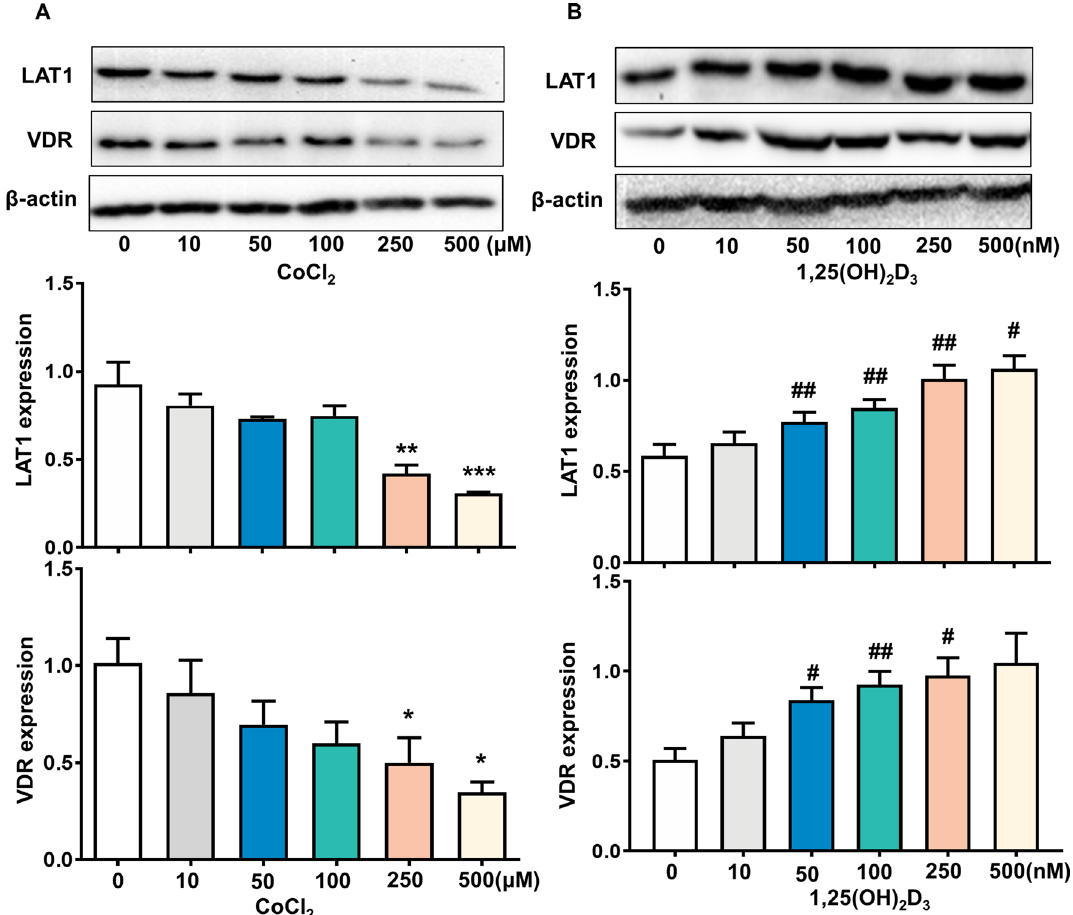
Figure 2. Effects of 1,25(OH) 2 D 3 and CoCl 2 on LAT1 and VDR expression in placental trophoblasts. ( A ) Protein expression for LAT1 and VDR in HTR-8/SVneo trophoblast cells treated with different concentrations of CoCl 2 . The bar graphs show relative protein expression for LAT1 and VDR after normalized against β-actin in each sample from three independent experiments. CoCl 2 induced a dose-dependent decrease in both LAT1 and VDR expression in trophoblasts. * P < 0.05, ** P < 0.01, *** P < 0.001, CoCl 2 treated vs control cells. ( B ) Protein expression for LAT1 and VDR in HTR-8/SVneo trophoblast cells treated with different concentrations of 1,25(OH) 2 D 3 . The bar graphs show relative protein expression for LAT1 and VDR after normalization with β-actin in each sample from four independent experiments. In contrast to CoCl 2 , 1,25(OH) 2 D 3 stimulated LAT1 and VDR expression in a dose-dependent manner in trophoblast cells. # P < 0.05, ## P < 0.01, 1,25(OH) 2 D 3 treated vs control